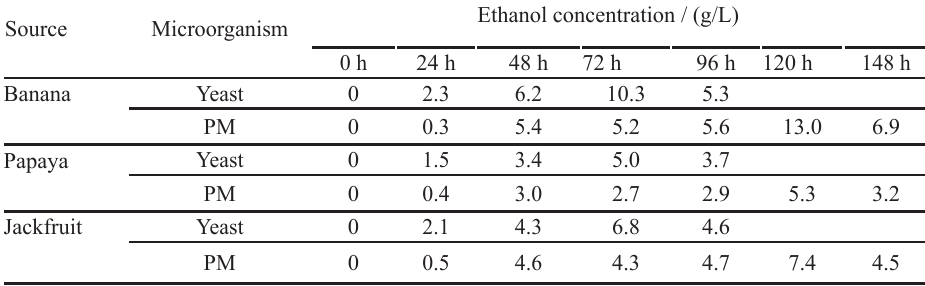
Table 3: Ethanol concentrations at 24 h time